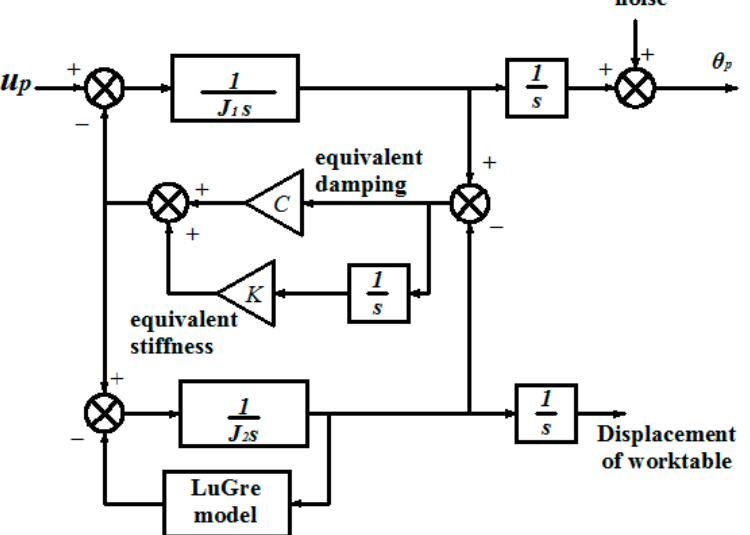
Figure 5. Block diagram of the two-inertia model.